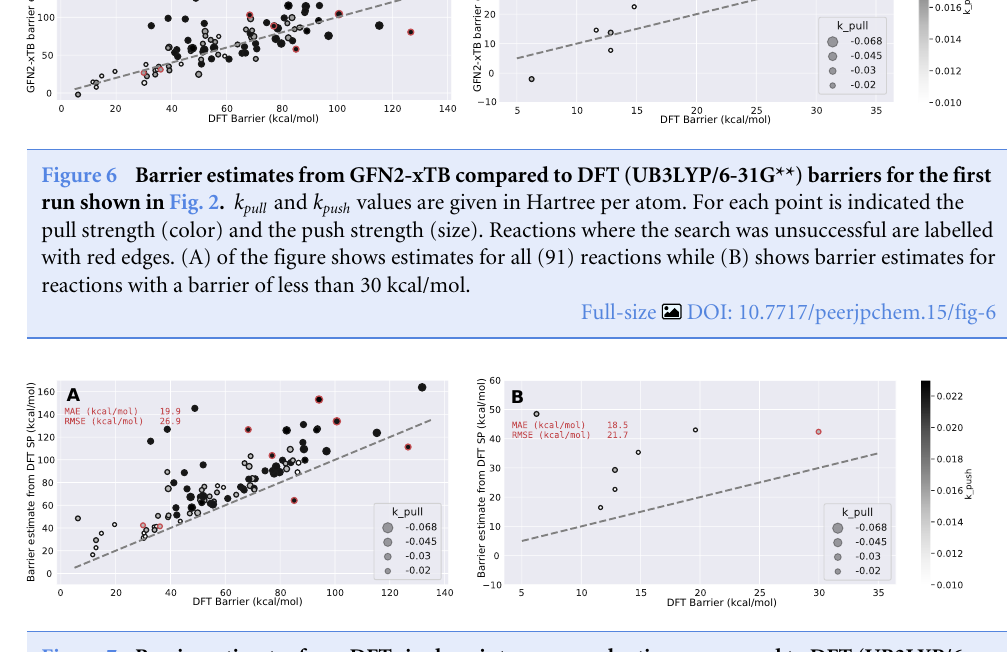
Figure 7 Barrier estimates from DFT single point energy evaluations compared to DFT (UB3LYP/6- 31G**) barriers for the first run shown in Fig. 2. k pull and k push values are given in Hartree per atom. For each point is indicated the pull strength (color) and the push strength (size). Reactions where the search was unsuccessful are labelled with red edges. (A) of the figure shows estimates for all (91) reactions while (B) shows barrier estimates for reactions with a barrier of less than 30 kcal/mol. DOI: